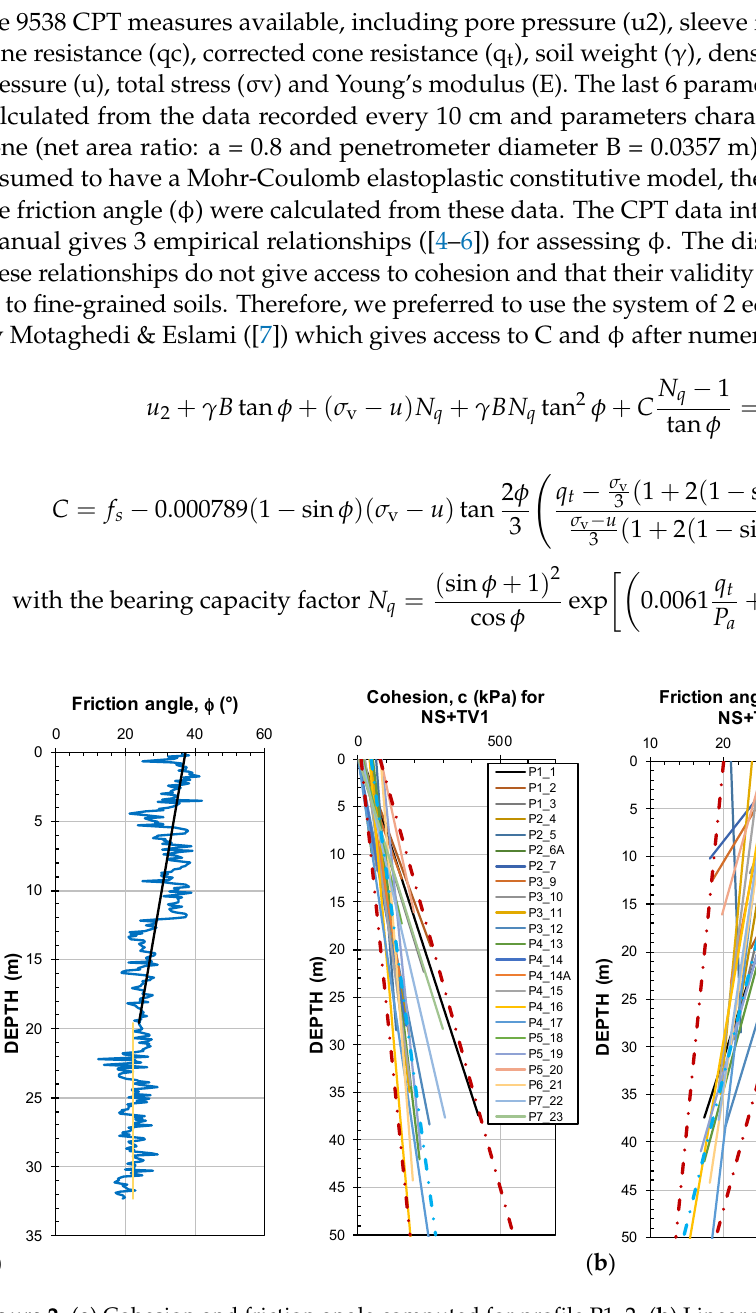
Figure 2. ( a ) Cohesion and friction angle computed for profile P1_2. ( b ) Linear variation of cohesion and friction angle for all CPT profiles for NS-TV1 unit; minimum and maximum limits in red and mean value in cyan.